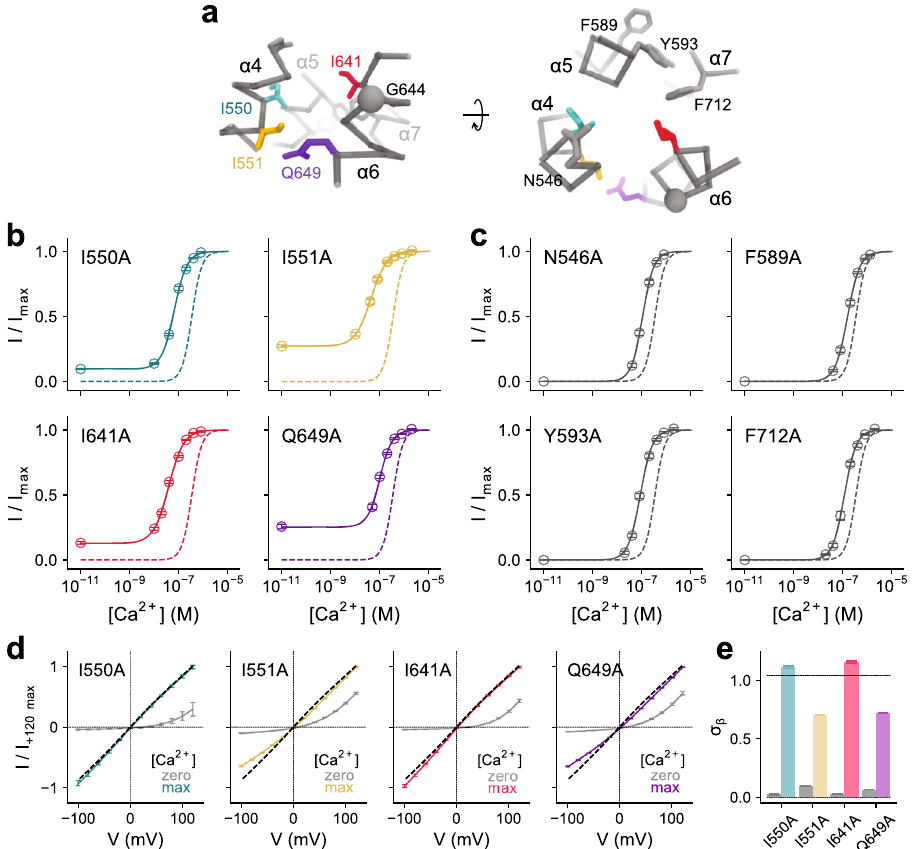
Fig. 2 Functional properties of mutants forming the gate. a C α representation of the entrance to the narrow region of the pore in TMEM16A. Sidechains of selected residues are displayed. The relationship of views is indicated. b , c Concentration-response relations of selected mutants of the inner neck region with left-shifted EC 50 for b , residues showing basal activity and c , residues not showing pronounced basal activity. Data are averages of the indicated number of patches shown in Supplementary Tables 1 – 3, errors are SEM. Solid lines are fi ts to the Hill equation. Dashed lines show the relation of WT. d Instantaneous I-V relations of mutants that display basal activity at zero and saturating Ca 2 + concentrations. Dashed lines show the relation of WT at saturating Ca 2 + concentrations. Data are averages of 5, 10, 7, and 13 patches for I550A, I551A, I641A, and Q649A respectively, errors are SEM. Solid lines are fi ts to a model of ion permeation (Eq. 2). e Values of σ β , corresponding to the relative rate of conduction at the inner pore close to the Ca 2 + binding site (see “ Methods ” ), for mutants displaying basal activity at zero and saturating Ca 2 + concentrations. Dashed line indicates the value of WT at saturating Ca 2 + concentrations. Bars indicate the best- fi t values of the averaged data shown in d . Errors are 95% con fi dence